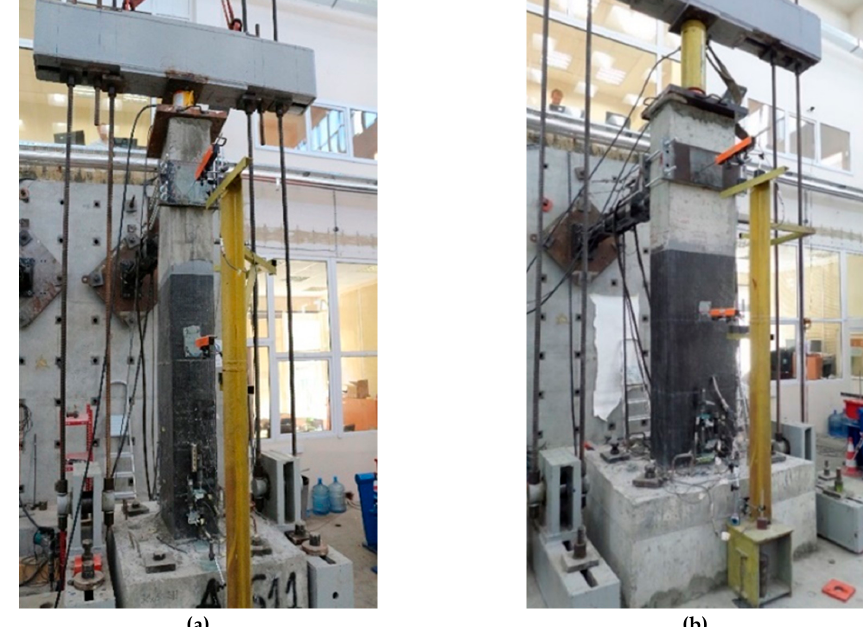
Figure 2. Test setup for ( a ) the first and ( b ) the second group of specimens.